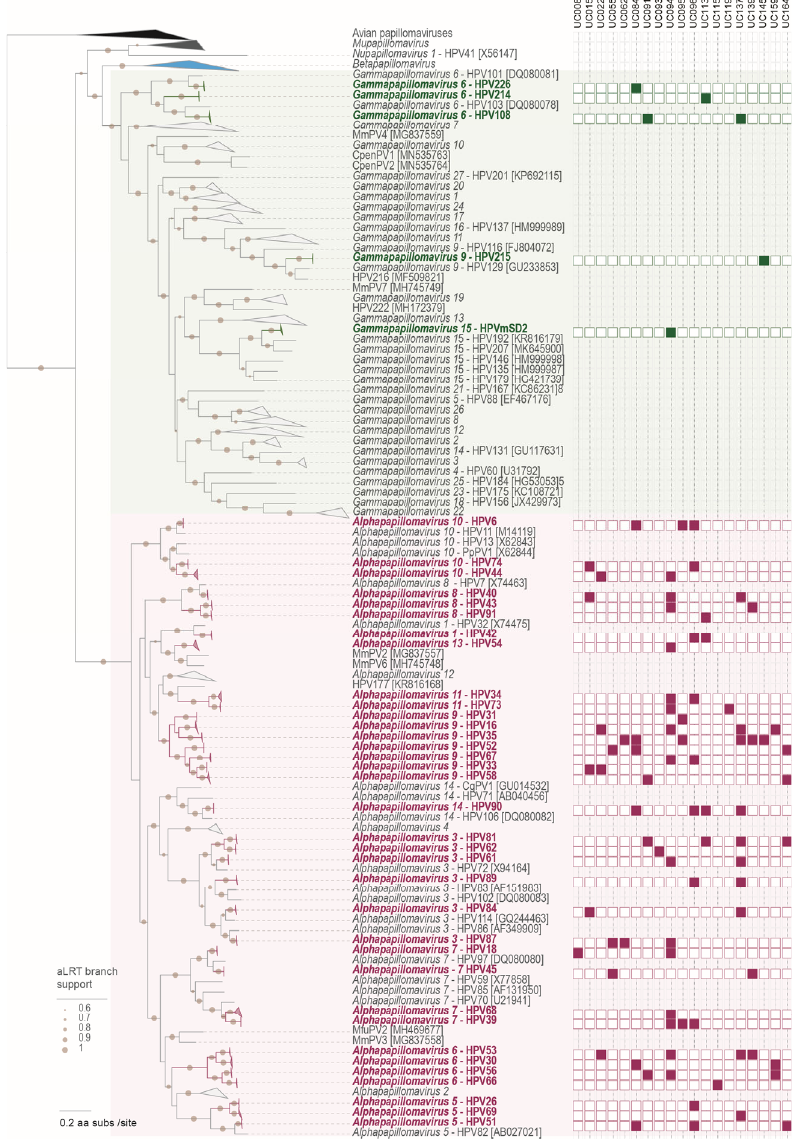
Figure 2. Maximum likelihood phylogeny of L1 amino acid sequences identified in this study. HPV species and types identified in 19 individuals are shown in bold font, and the colored boxes represent the presence of HPVs in that individual. Branches with >0.6 approximate likelihood-ratio test (aLRT) branch support are shown. This analysis includes all complete HPV genomes identified in the viral and whole community metagenome sequencing projects.